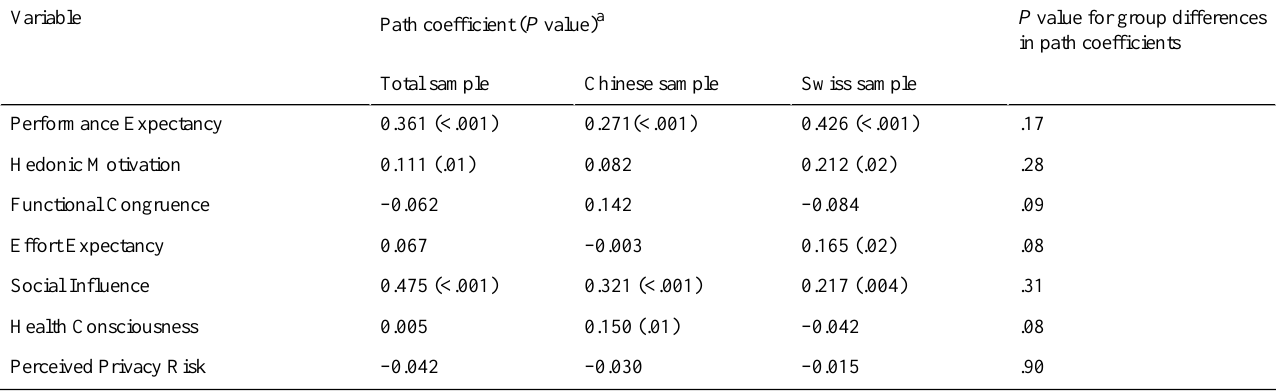
Table 7. Group-specific path coefficients for each variable’s influence on behavioral intention and multigroup